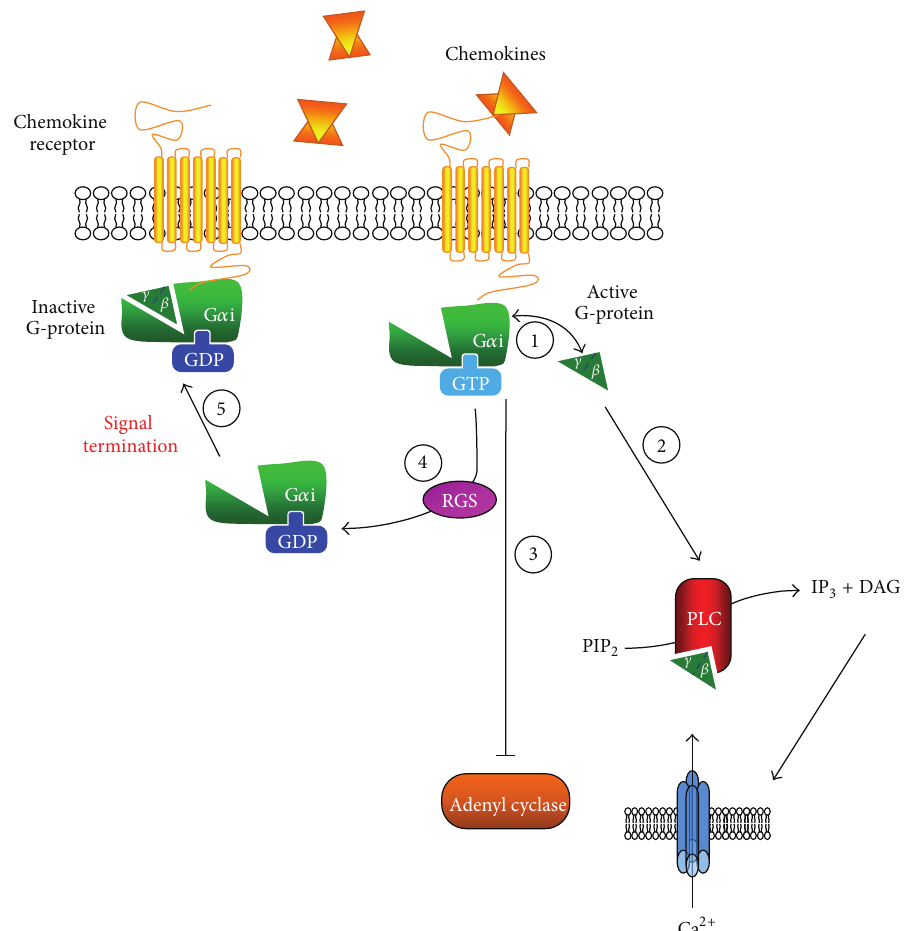
Figure 3: RGS proteins in chemokine-mediated GPCR signalling. Following receptor activation and G-protein coupling, the G 𝛼 and G 𝛽𝛾 subunits dissociate (1) and regulate downstream effector functions such as activation of PLC (2) and inhibition of adenyl cyclase (3). The 𝛽𝛾 subunit activates PLC, leading to local production of IP3 and DAG from PIP2. IP3 activates calcium channels which results in a release of calcium. RGS proteins enhance the GTPase activity of the G 𝛼 -subunit, controlling the rate of GTP hydrolysis (4). This promotes the formation of the inactive G-protein and subsequently terminates chemokine signalling